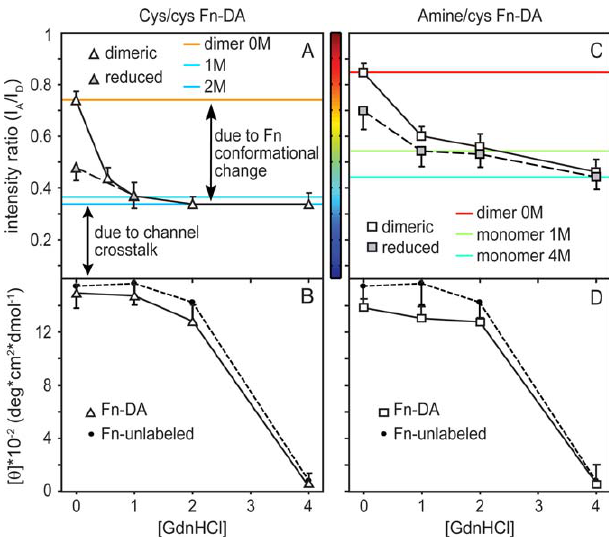
Figure 2. Fn-DA Unfolding in Denaturant Solution Probed by FRET and Circular Dichroism Dimeric Fn-DA (open symbols) or monomeric Fn-DA generated by reduction in 50 mM DTT for 60 min (shaded symbols) with donors and acceptors labeled exclusively on cysteines (cys/cys Fn-DA; A and B) or on amines and cysteines (amine/cys Fn-DA; C and D) was unfolded in 0, 0.6, 1, 2, and 4 M GdnHCl. I A / I D was quantified by calculating the ratio of measured acceptor and donor intensities using 12-nm bandwidths from 566–572 nm and 514–526 nm, respectively (A and C). Mean residue ellipticity was measured for labeled Fn-DA and Fn-u (black circles) in GdnHCl (B and D). Horizontal colored lines for dimeric amine/cys Fn-DA in 0 M GdnHCl, monomeric amine/cys Fn-DA in 1 and 4 M GdnHCl, and dimeric cys/cys Fn-DA in 0, 1, and 2 M GdnHCl are shown based on an artificial color code ranging from 0.05 to 1.0 I A / I D units that is identical to that used in Figures 3–6. Bar width corresponds to the standard deviation of the mean values from three different measurements in